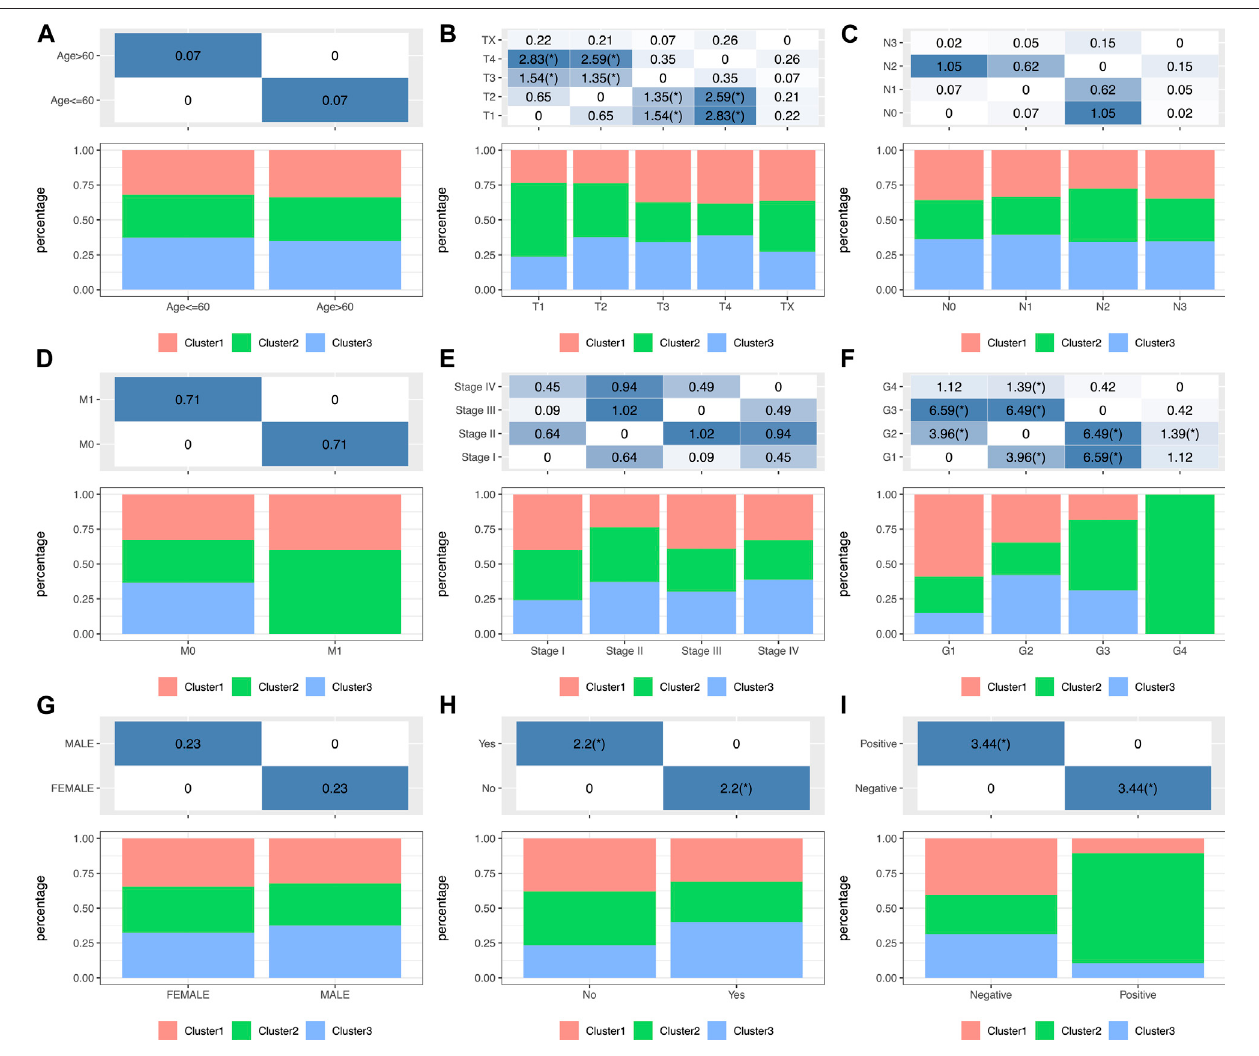
FIGURE 2 | Factor analysis of three HNSCC subtypes based on clinical characteristics: age (A) , T staging ratio (B) , N staging ratio (C) , M staging ratio (D) , stage ratio (E) , histological grade ratio (F) , gender ratio (G) , smoking history (H) and HPV status (I) distribution in the three HNSCC subtypes.